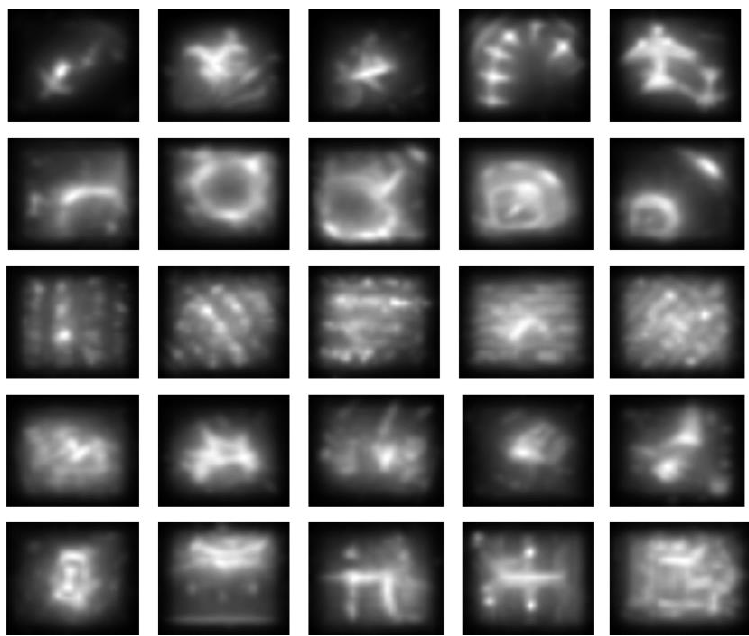
Figure3. Respective saliency maps of images in Figure 2